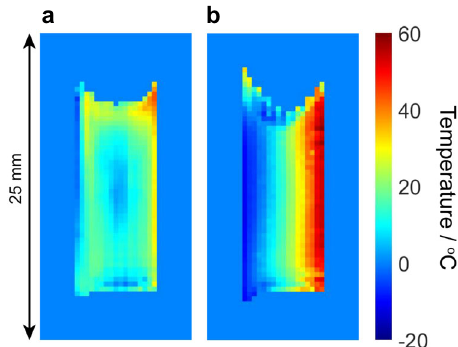
Fig. 3 Temperature maps obtained from the vertical electrode cell. The cells contained MPN with 0.05 M Co 2 + /3 + (bpy) 3 (TFSI) 2/3 in a liquid and b gel form. In both cases, the target electrode temperatures were − 30 °C (cold/left) and 60 °C (hot/right). The uncertainty in temperature for each pixel in these and subsequent images is ±2.5